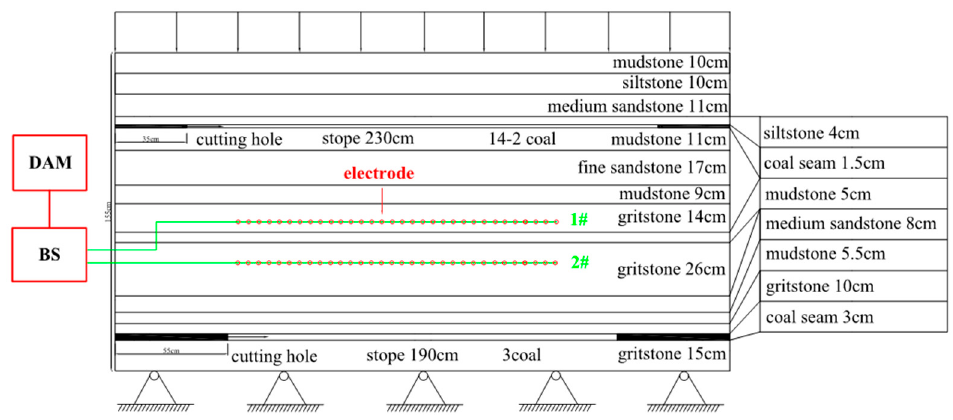
Figure 3. Engineering geomechanics model diagram of working face 8117 of Majiliang coal mine.